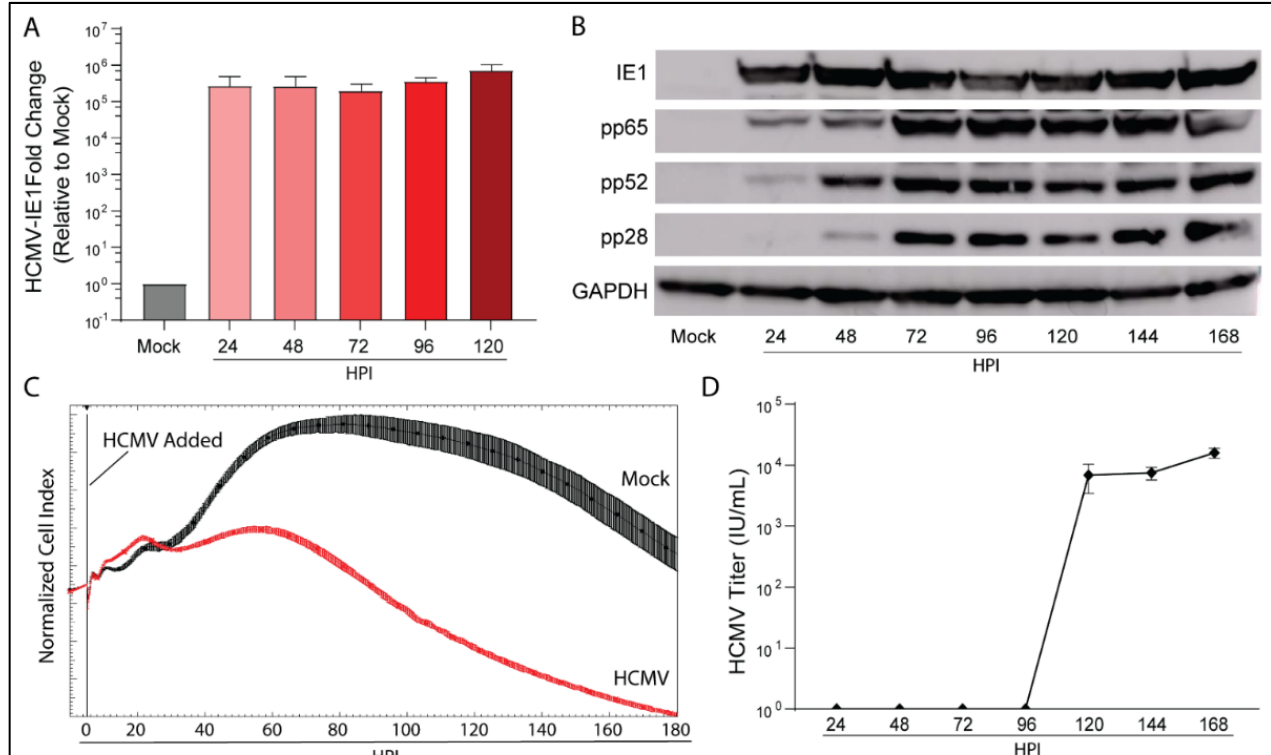
Figure 1. HCMV can productively infect the glioblastoma cell line LN-18. LN-18 cells were infected with HCMV Towne strain and ( A ) transcriptional and ( B ) translational profiles of key HCMV proteins were examined by qPCR and WB. Mock infected cells served as controls. ( C ) Dynamic monitoring of LN-18 Cell Index (impedance) during HCMV infection using xCELLigence. ( D ) Viral titers of cell culture supernatant were quantified using an immunofluorescent based assay. Graphs represent pooled data from three independent experiments. Mean ± the SEM of at least 3 triplicates.